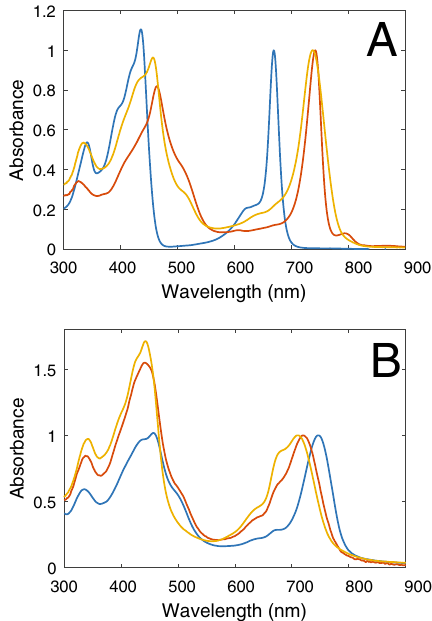
Figure 1. Absorption spectra of ( A ) BChl c monomers in ethanol (blue line) and aggregates in chlorosomes from Cfl.aurantiacus (red) and Cba. tepidum (yellow) in a buffer, and ( B ) pure BChl c injected to a buffer by the "fast" method (which forms probably dimers 33 ) (yellow) and aggregates prepared by the "fast" (red) and "slow" (blue) method with BChl c to β-carotene stoichiometric ratio of 1:0.3. All spectra were normalized to the maximum of the Q y